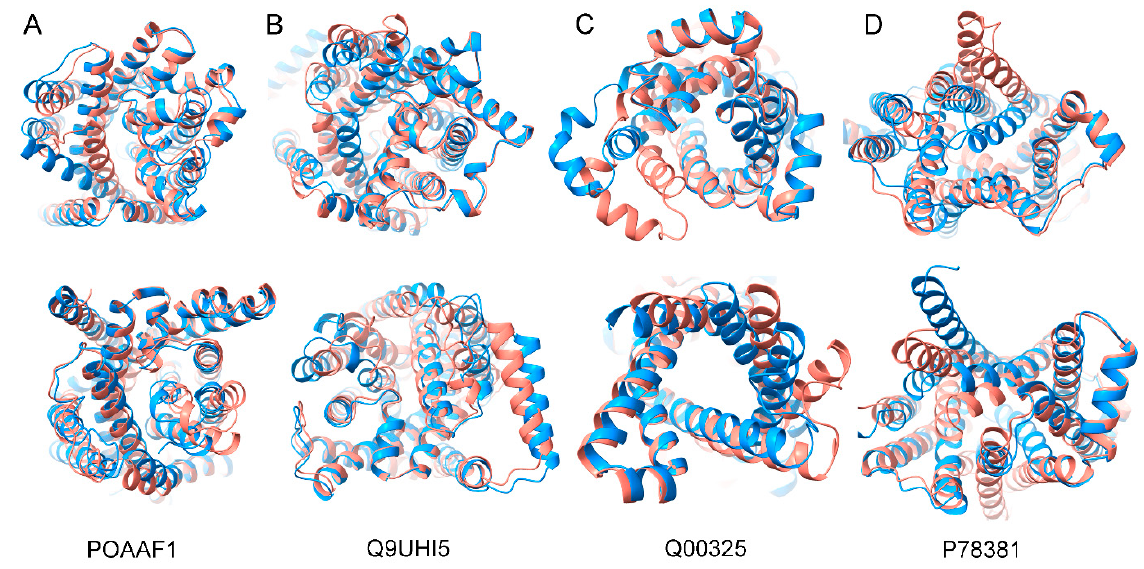
Figure 4. Structural alignment of the other transporters between the predicted structure of the wild type (salmon) and mutant (dodger blue) with the UniProt numbers POAAF1 ( A ), Q9UHI5 ( B ), Q00325 ( C ), and P78381 ( D ).